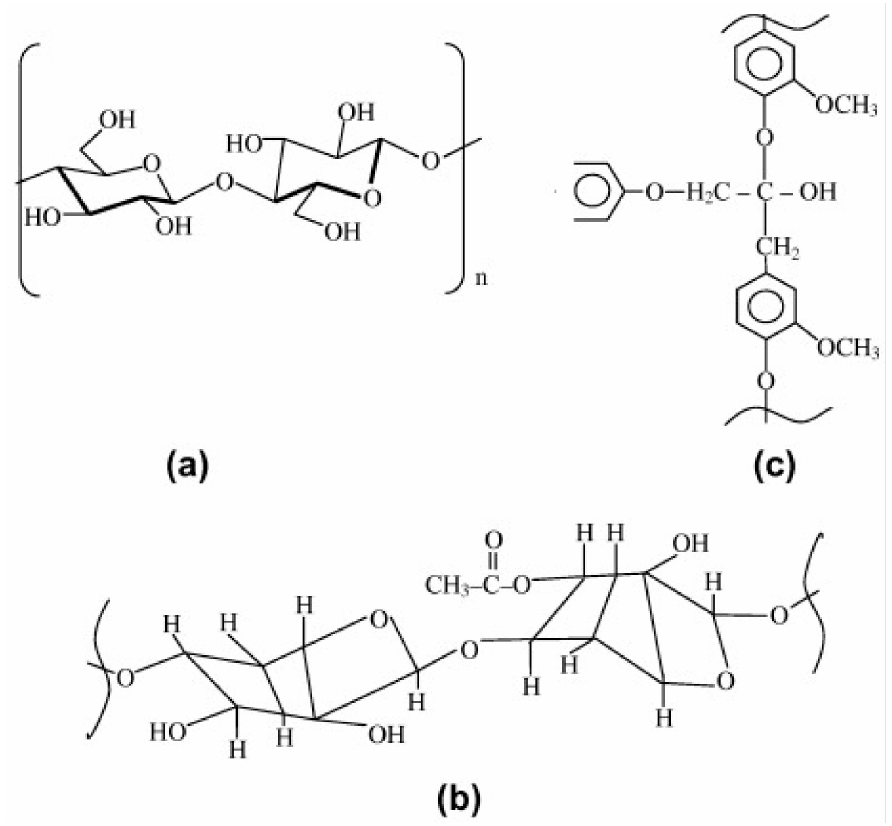
Figure 8. General structures of ( a ) cellulose, ( b ) hemicellulose and ( c ) lignin. Reprinted with permission from Elsevier